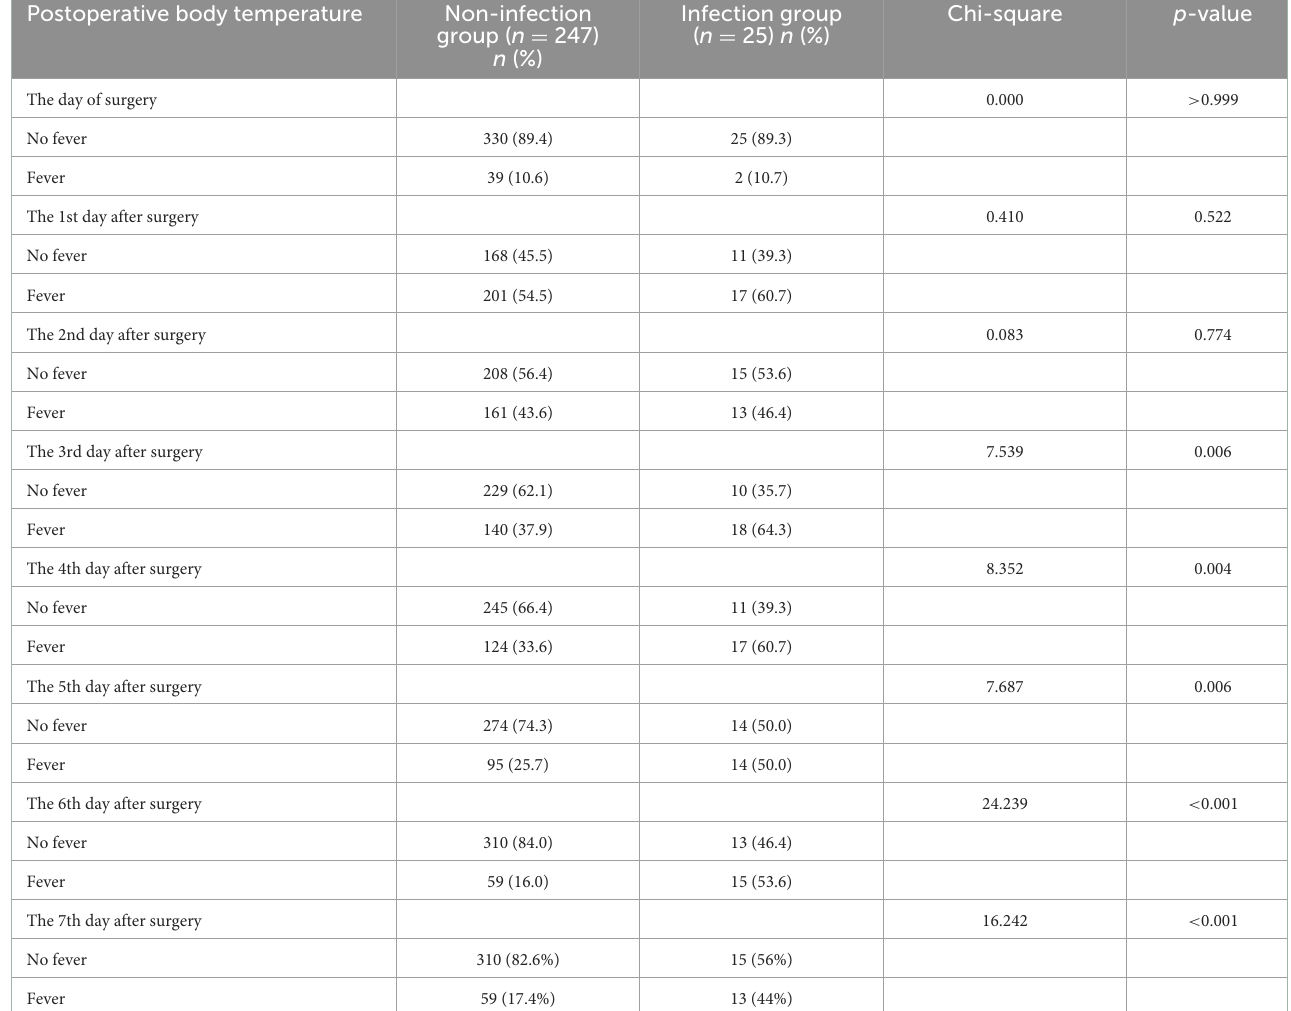
TABLE 6 Comparison of postoperative fever between the non-infection and infection groups. Postoperative body